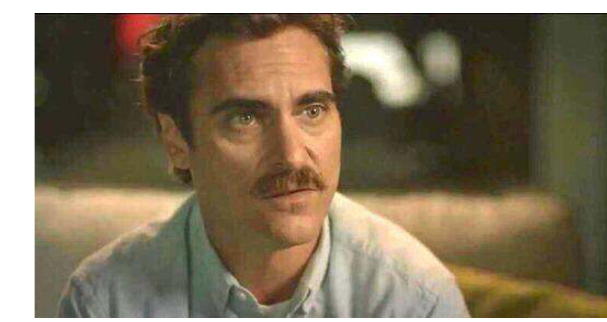
Figure 2. Theodore felt not strong enough for a real